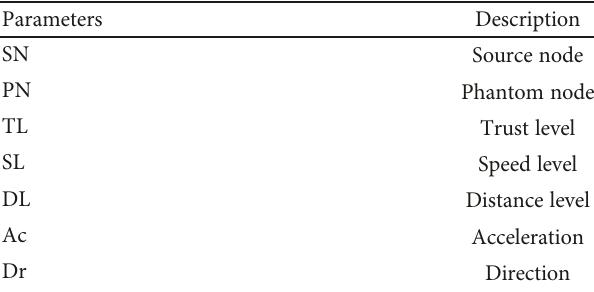
Table 2: Parameter description.